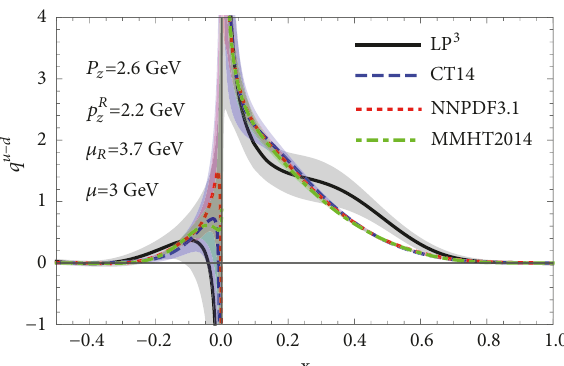
Figure 20: LP 3 ’s final unpolarized PDF at 𝜇 = 3 GeV calculated from RI/MOM quasi-PDF at nucleon momentum 𝑃 𝑧 = 2.6 GeV, compared with CT14nnlo (90CL) [210], NNPDF3.1 (68CL) [211], and MMHT2014 (68CL) [212]. Source: [199] (arXiv), reprinted with permission by the